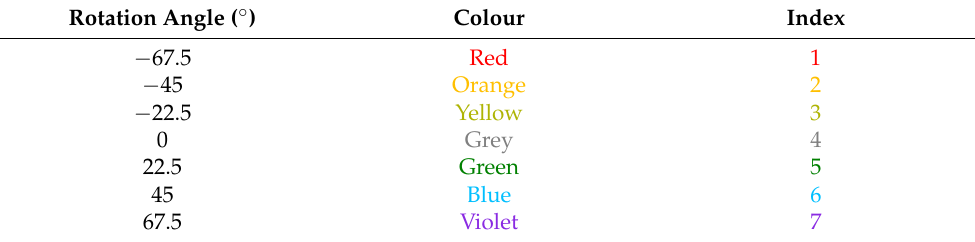
Table 1. Colour coding and indexing for seven discrete angles for which lambda circles are generated (see Table 2) and shown in the skeletonised two-dimensional images of the field of audition in Figures 1–4.